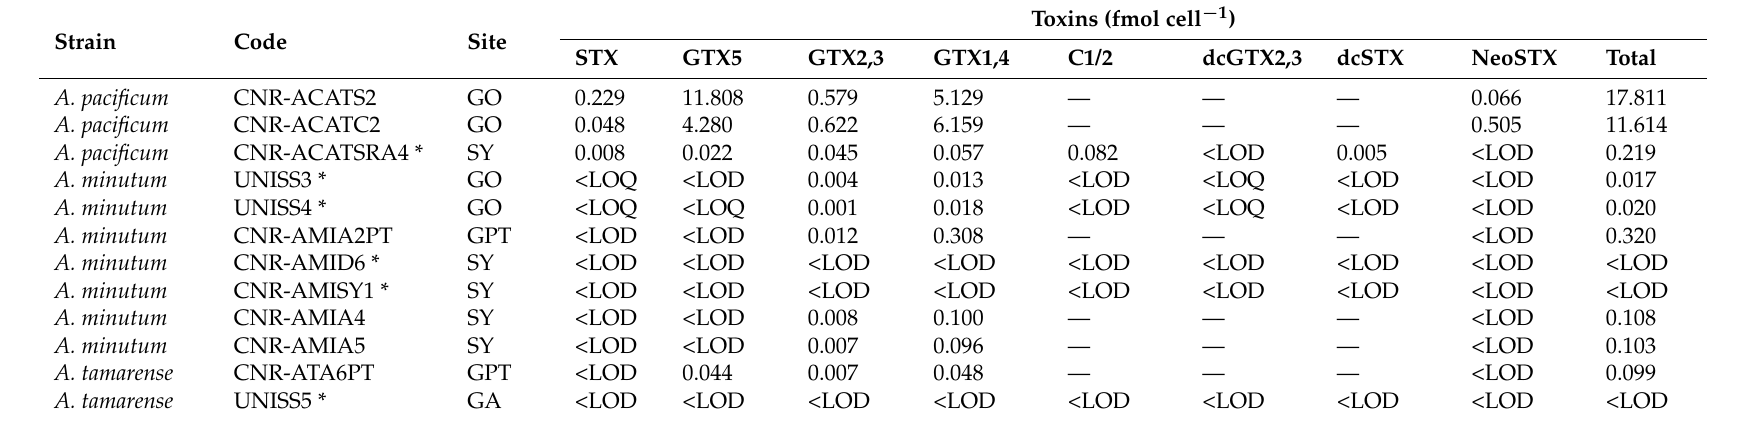
Table 2. List of Alexandrium isolates analysed in this study and relative content in